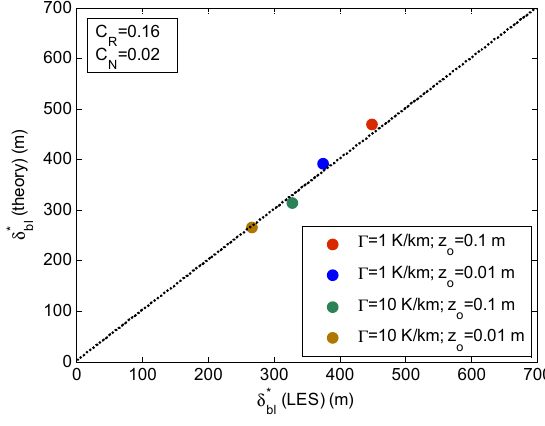
Figure 5. Correlation between δ (cid:2912)(cid:2922)∗ (theory) calculated from Equation (6) (with C and C = 0.02 ) and δ (cid:2912)(cid:2922)∗ (LES) directly obtained from (cid:2898)